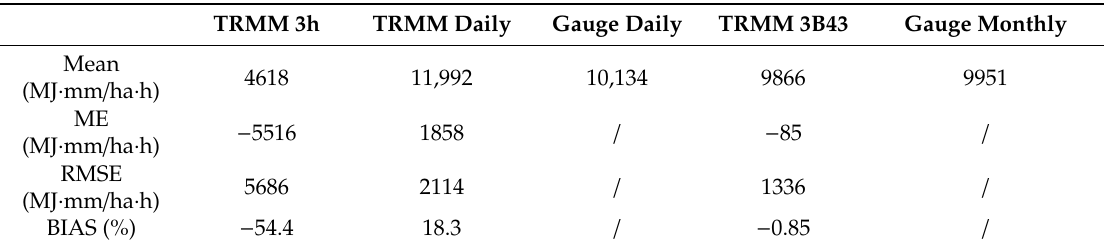
Table 2. Results of bias analysis for annual rainfall erosivity from the TRMM 3h, daily and 3B43 rainfall